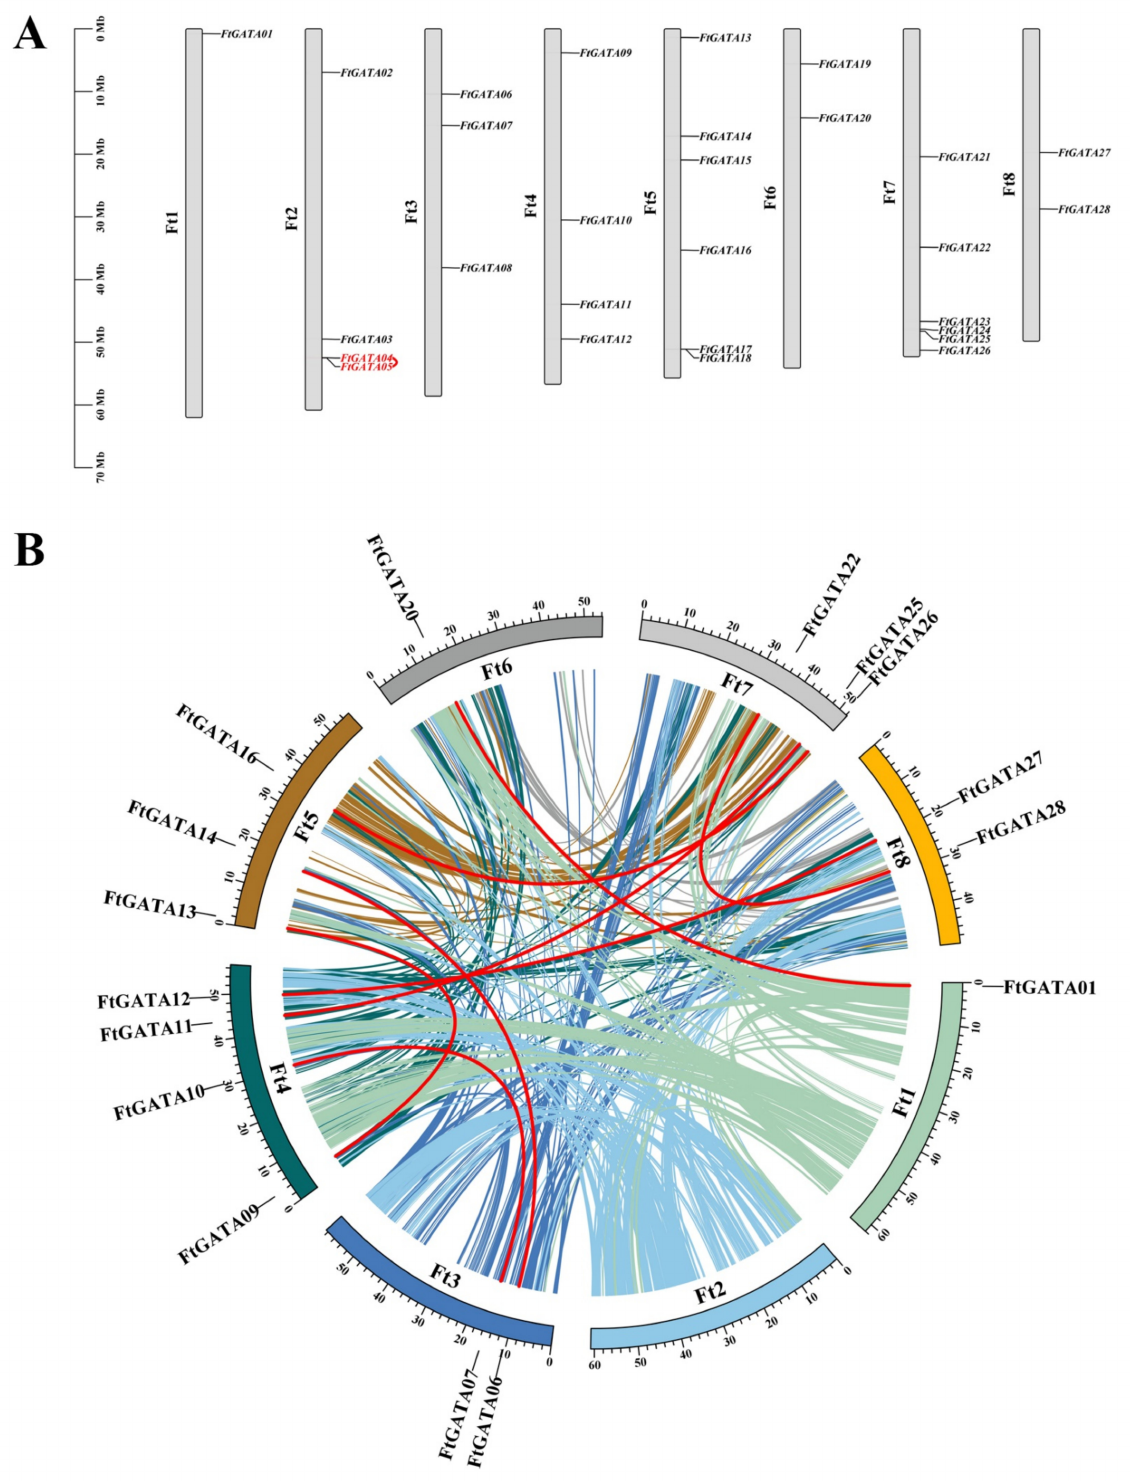
Figure 4. ( A ) Chromosomal distribution of GATA genes in Fagopyrum tataricum . The gray rectangular bars represent the chromosomes of F. tataricum ; red fonts and lines represent gene tandem repeats; each corresponding chromosome number is marked on its left side, named Ft1-Ft8, and the 0–70 Mb scale bar on the left-hand side represents chromosome length. ( B ) Chromosome distribution and gene duplication relationship of GATA genes in F. tataricum . Colored lines indicate the collinear regions in the genomes of F. tataricum , and red lines indicate duplicated GATA gene pairs. The chromosome number is shown inside each